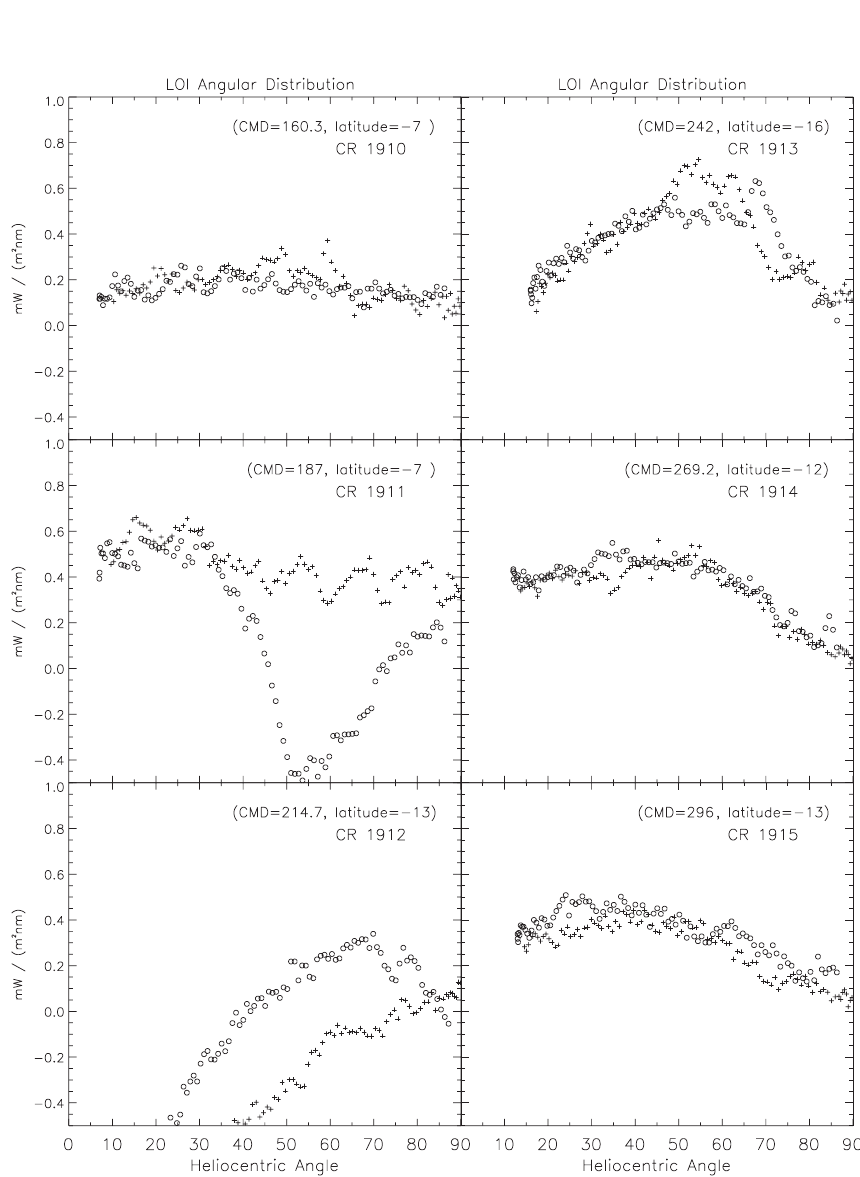
Figure 20: Evolution of the 500 nm spectral irradiance originating from AR 7978 as it rotated across the disc. When the AR was east of the central meridian, the measurements are plotted by crosses, when it was West of it, by circles. CMD is the date of central meridian passage. Image reproduced by permission from Ortiz (2003); see also Ortiz et al.